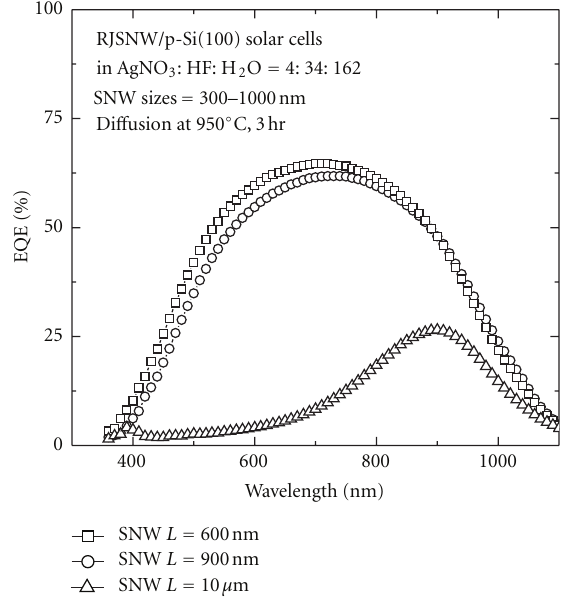
Figure 12: External quantum e ffi ciencies (EQEs) of various RJSNW solar cells, measured for incident light with wavelengths of 350 ∼ 1100 nm. Etching conditions were aqueous AgNO 3 /HF/H 2 O mixture chemical solution in a ratio of 4:34 :162 (volume) at 25 ◦ C for (a) 1.5, (b) 3, and (c) 30